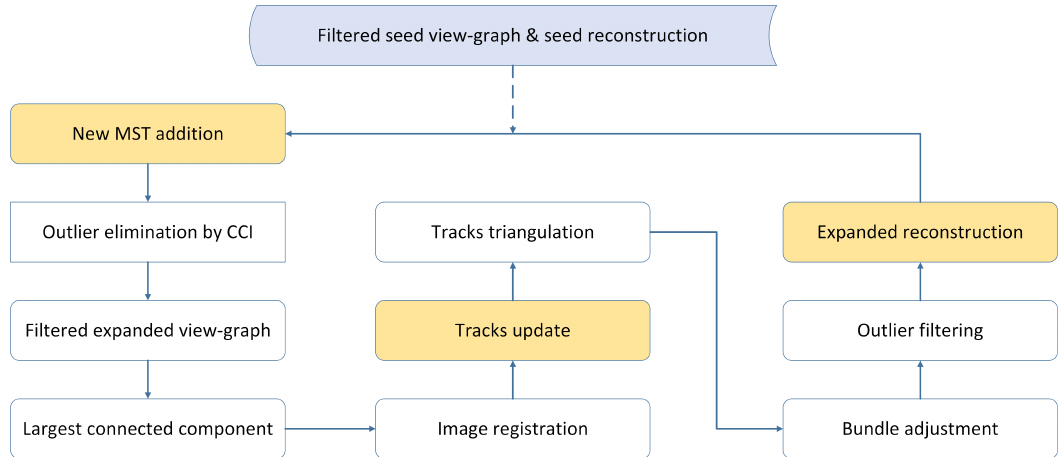
Figure 8. Workflow of expansion of seed reconstruction.